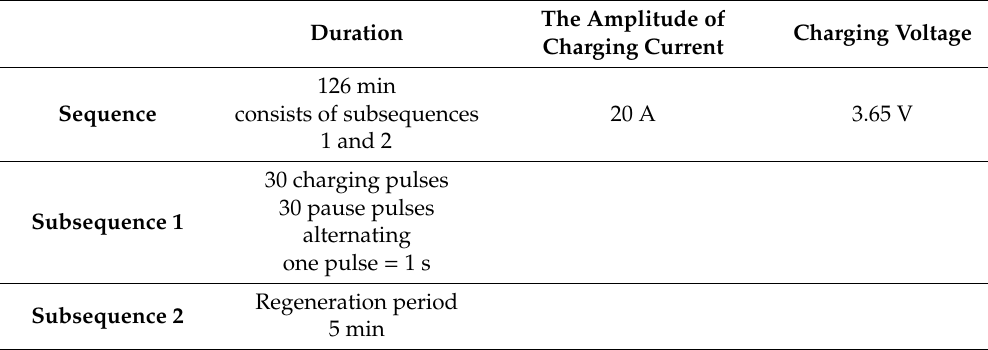
Table 3. The setting of sequences of regeneration algorithm for deeply discharged cell.